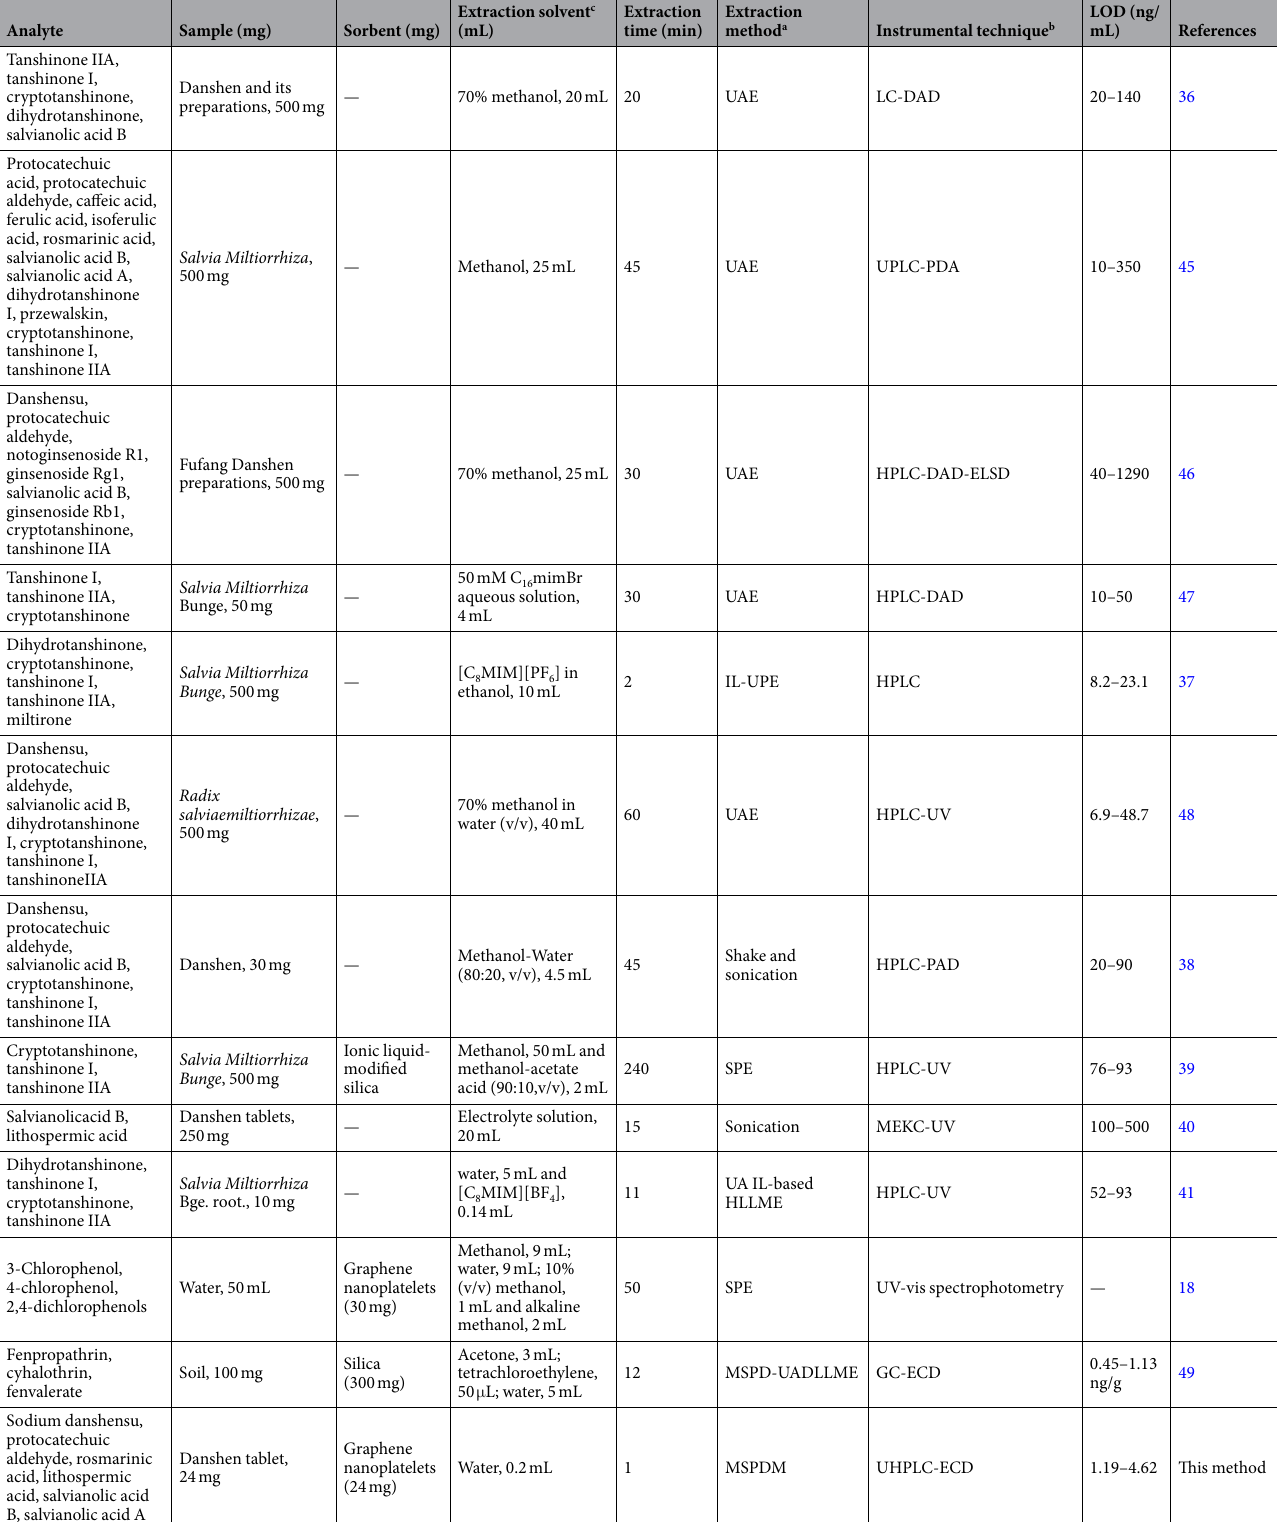
Table 3. Comparison of the proposed method with previously reported methods. a UAE, ultrasound assisted extraction; IL-UPE, ionic liquid-based ultrahigh pressure extraction; SPE, solid-phase extraction; UA